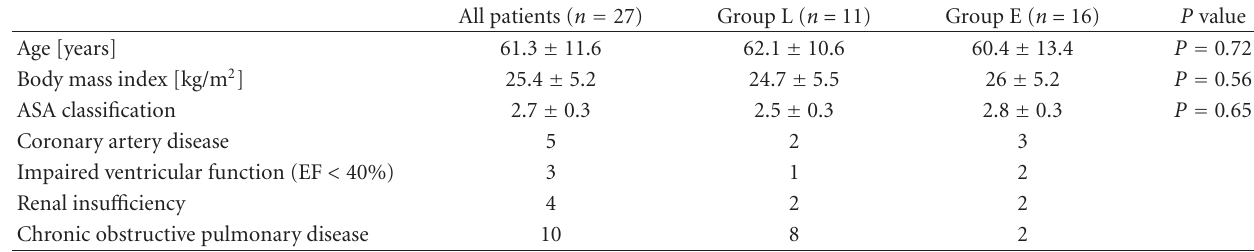
Table 1: Patient’s characteristics and comorbidities. Patients did not di ff er significantly ( P > 0 . 05) between group L and group E regarding age, body mass index, and ASA classification.